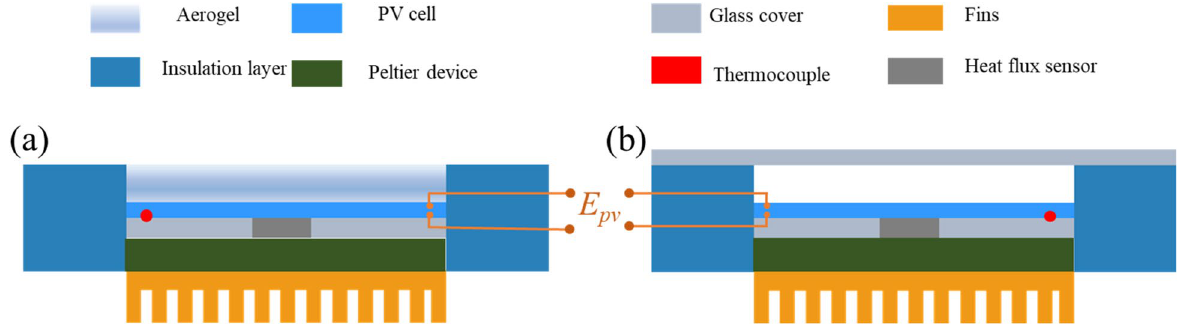
Fig. 4 Schematic of the A-PV/T and T-PV/T collectors for efficiency testing